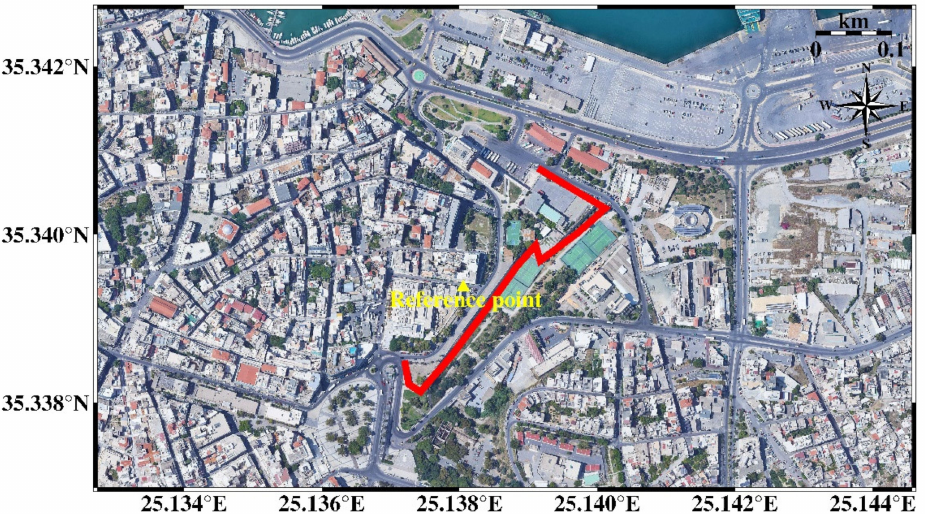
Figure 4. The location of the reference point marked by the yellow pin during D-InSAR and MSBAS processing of both ascending and descending SAR images. The background is Google Map. The red line represented the outline of the Sampionara